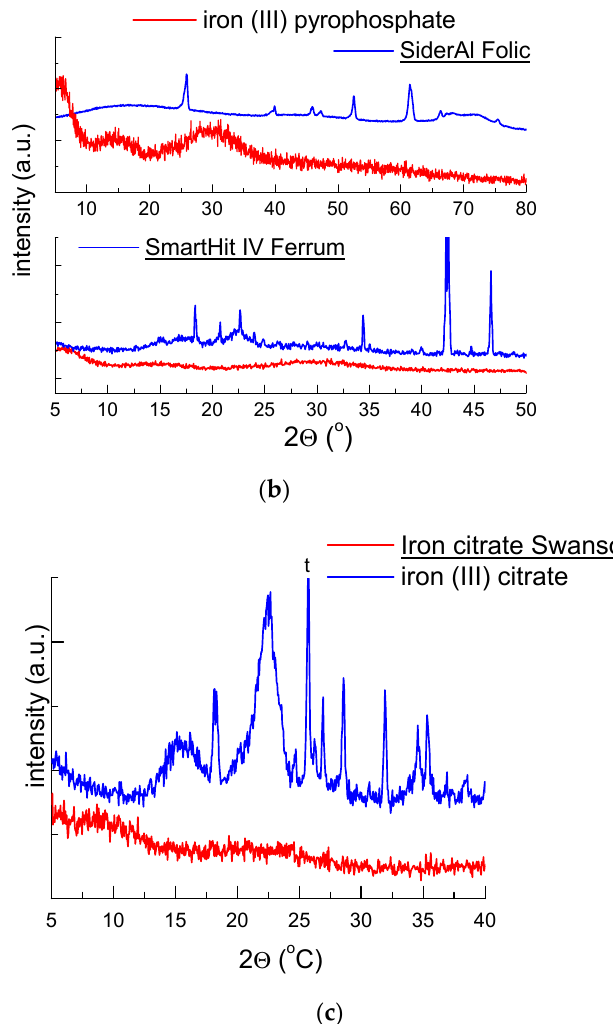
Figure 6. Diffraction pattern for dietary supplements: ( a ) SiderAl Folic, Dicofer Junior, Actiferol , ( b ) SiderAl Folic , SmartHit IV Ferrum , ( c ) Iron citrate Swanson , s—sorbitol, t—TiO 2 , *—vitamin C.